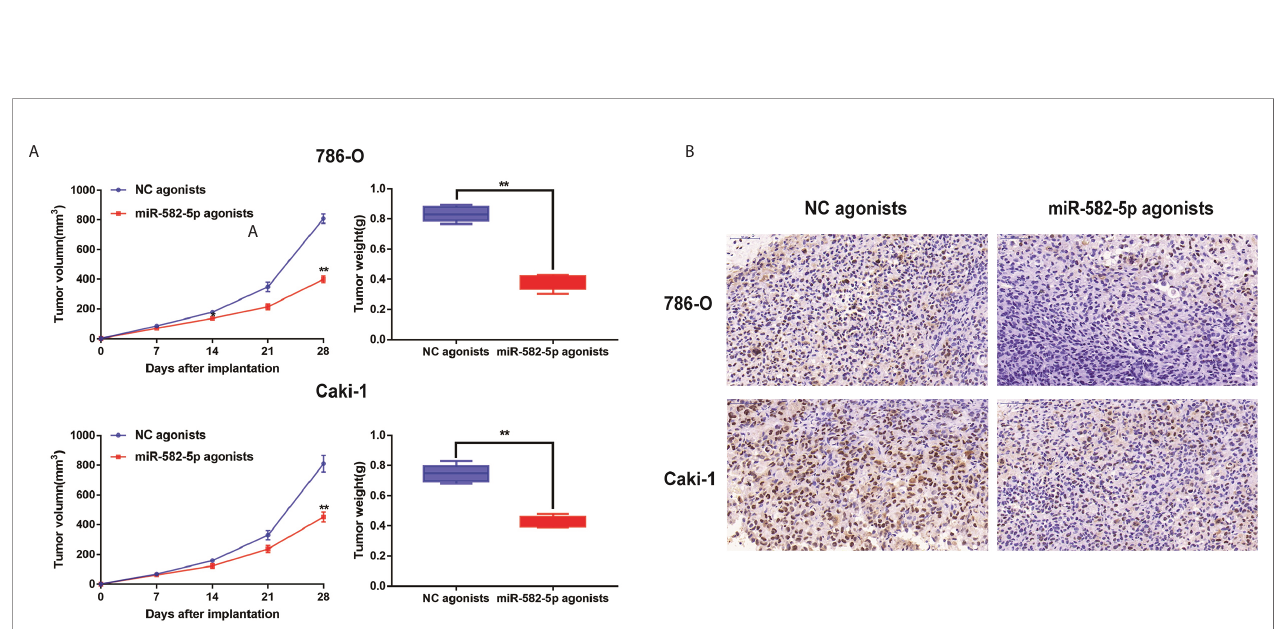
FIGURE 2 | MiR-582-5p regulated cell proliferation and invasion. (A) The effect of miR-582-5p mimics was identi fi ed by qRT-PCR in 786-O and Caki-1 cells. (B) Representative pro fi le of cell growth was examined by CCK-8 assay in 786-O and Caki-1 cells after transfection with miR-582-5p mimics compared with the control. (C) Cell proliferation was determined by colony-formation assay of impacts of miR-582-5p in 786-O and Caki-1 cells. (D) Representative images revealing the invasion capacities of impacts of miR-582-5p in in 786-O and Caki-1 cells. The data are shown as the mean ± SD (* P < 0.05; ** P < 0.01). The experiments were repeated three times with similar results.